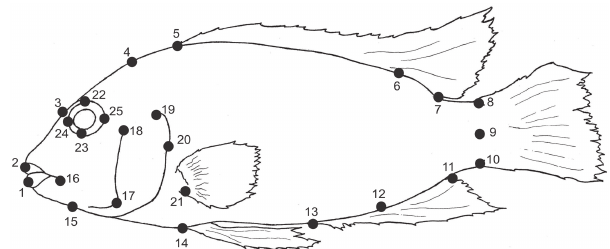
Fig. 2. Landmarks recorded in this study. 1. Anterior end of the lower maxilla 2. Anterior end of the upper maxilla 3.